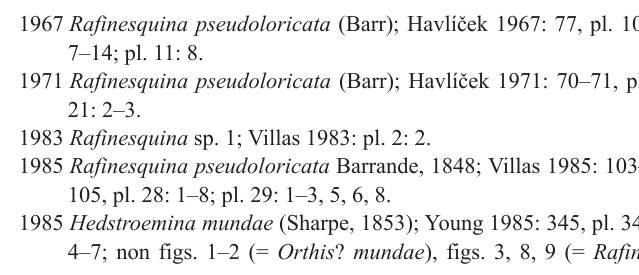
Fig. 17. Ventral valves of rafinesquinine brachiopod Rafinesquina ( Mesogeina ) pseudoloricata (Barrande, 1848); lower–middle Katian (Ka1–2), Upper Ordovician; Zahorany Formation, Bohemia, Czech Republic (A, B); Upper Tiouririne Formation, Morocco (C); Porto de Santa Anna Formation, Portuguese Central Iberian Zone, Portugal (D); Peña del Tormo Member of the Fombuena Formation, Iberian Chains, Spain (E, F). A . MPZ 2015/1391, internal mould (A 1 ), latex cast of interior (A 2 ) and exterior (A 3 ). B . MPZ 2015/1392, internal mould of an incomplete valve. C . MPZ 2015/1393, ventral internal mould. D . IGM-2952A, latex cast of ventral exterior. E . DPZ-359, internal mould of an incomplete valve. F . DPZ-362, internal mould (F 1 ) and latex cast of exterior (F 2 ). Scale bars 2